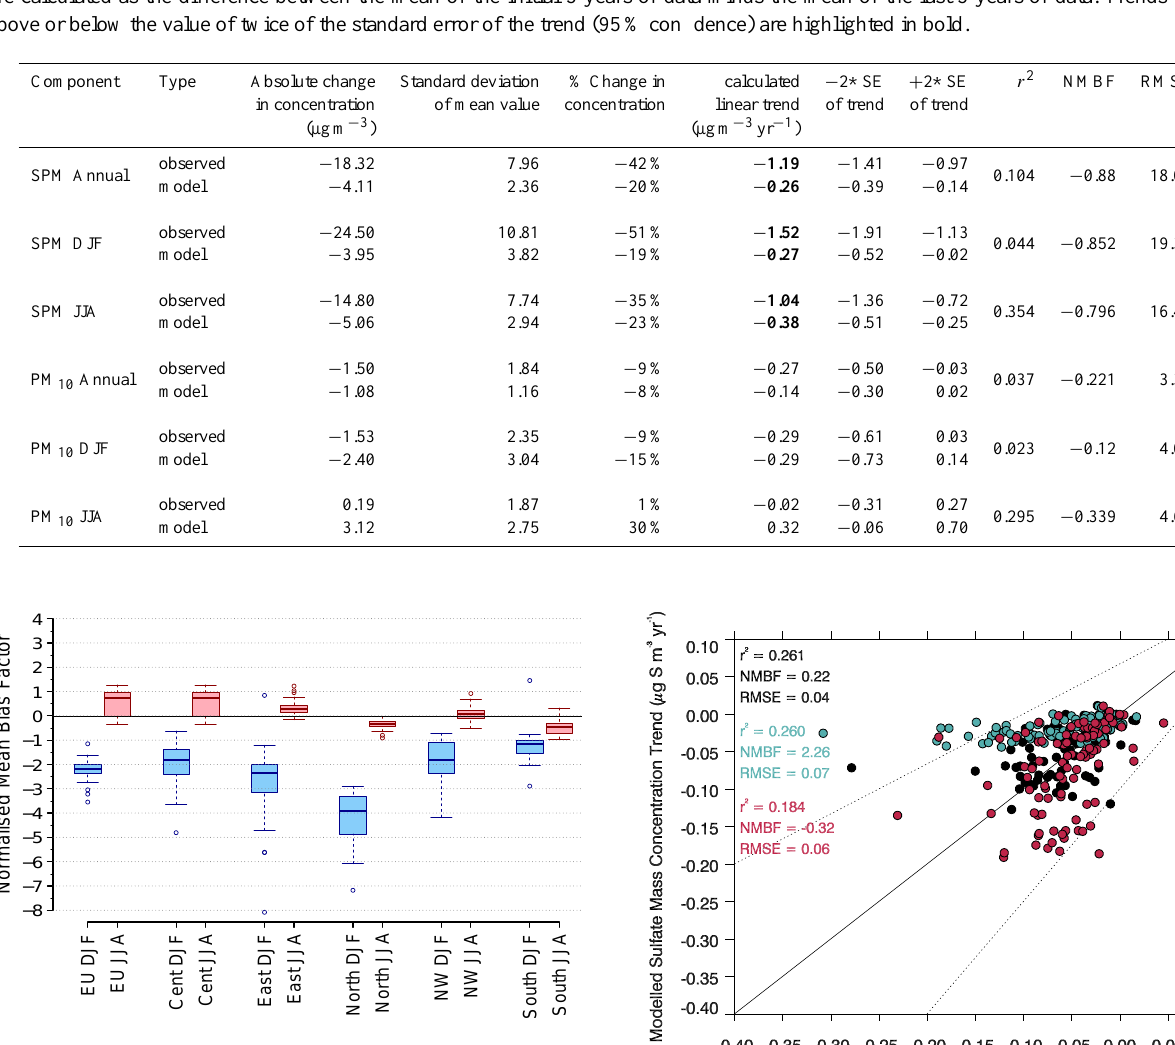
Figure 6. European and sub-regional normalised mean bias factors for summertime (red) and wintertime (blue) sulfate aerosol mass concentrations across all the years that data were available. The solid line shows the median value, the boxes show the 25th and 75th percentile values with the error bars showing the maximum and minimum values and the circles representing outliers (values > 1.5 × interquartile range).